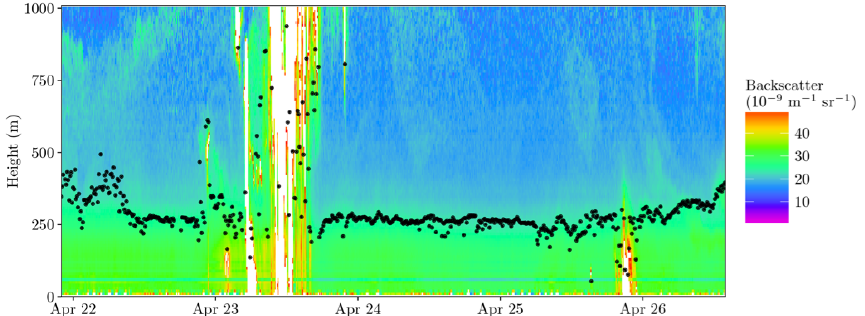
Figure 8. Backscatter profiles measured by a ceilometer from 22 to 27 April 2012 at the Villum research station, high Arctic. The bar to the right shows the backscatter density. The circles show the height of the boundary layer.